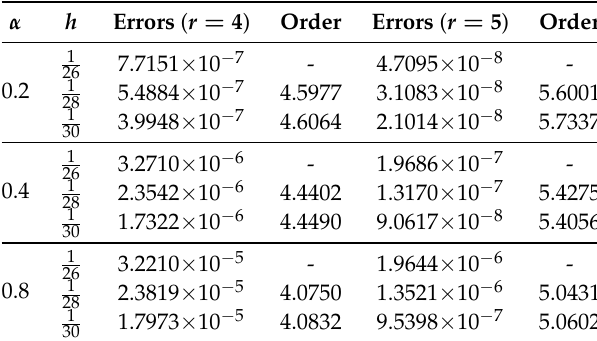
Table 7. Numerical results for Example